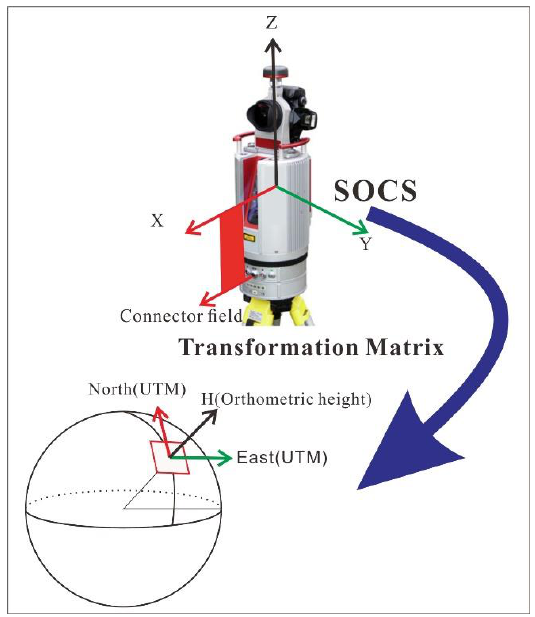
Figure 5. A conceptual sketch illustrating the georeferencing process employed in the rapid surveying method. The rapid surveying method directly transforms TLS points from the scanner’s own coordinate system (SOCS) to the regional geodetic coordinate system (ENH: East – North – Height). In this study, the RiSCAN PRO 2.0 (http: // www.riegl.com / products / software-packages /